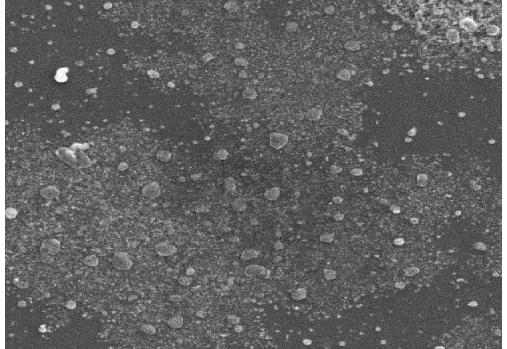
Figure, 3: Crystalline clusters of SNPs obtained by scanning electron Microscopy (2000X)